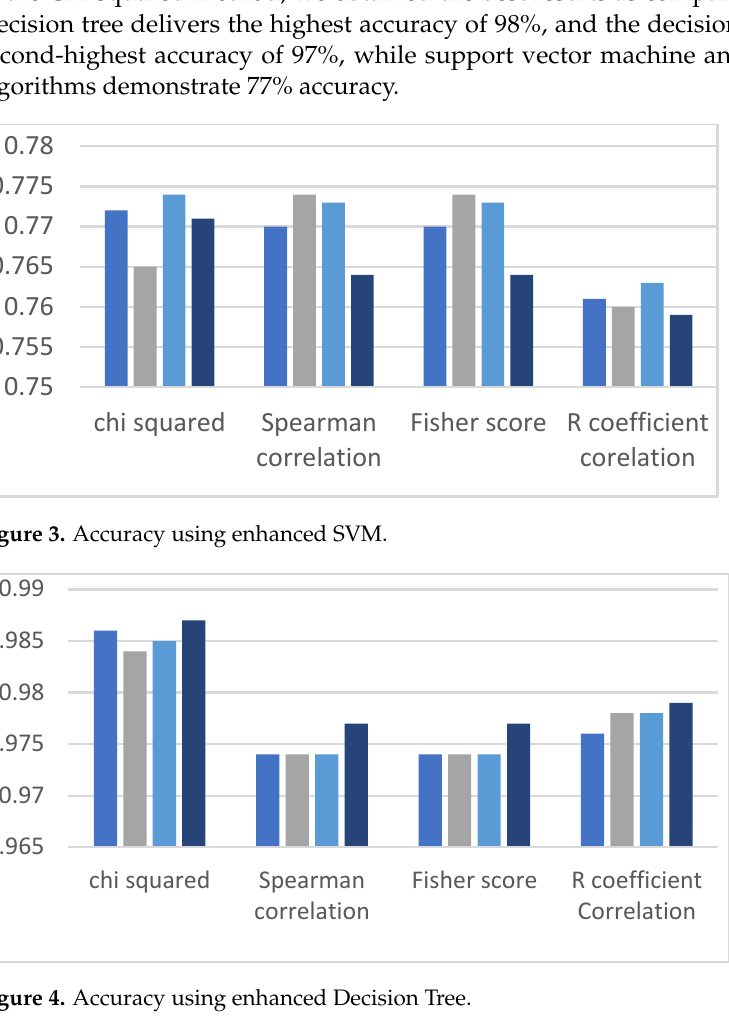
Figure 5. Accuracy using enhanced NN. Figure 6. Accuracy using enhanced LR.